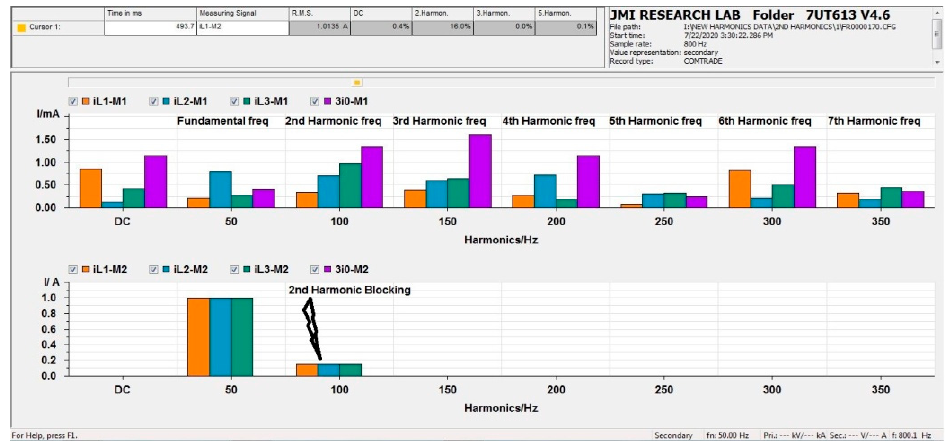
Figure 9. 2nd HB at 1000 mA Rated current & 18% of Inrush current condition.